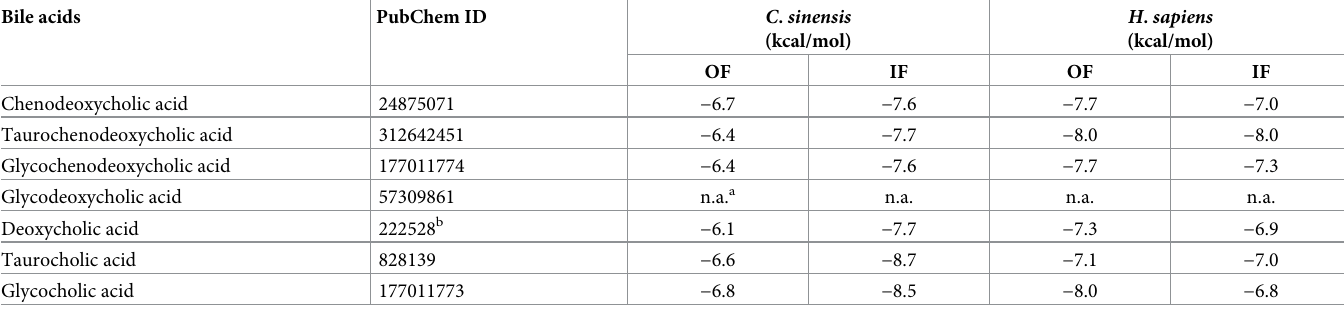
Table 3. Binding energy for bile acids to OF-/IF-SBAT of Clonorchis sinensis and OF-/IF-ASBT of Homo sapiens using AutoDock